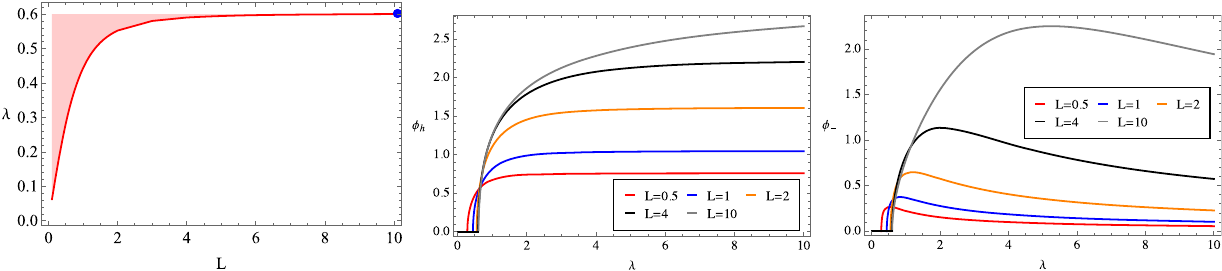
the function of λ with different AdS radius L ; Right: the corresponding scalar charge of the black hole φ − behaves with different AdS radius